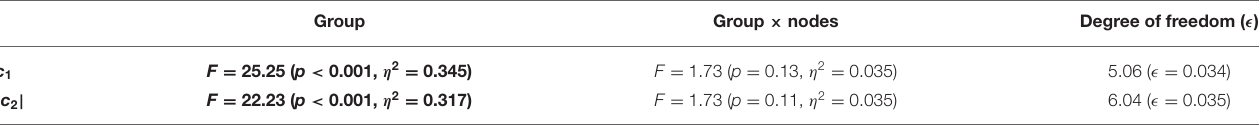
Frontiers in Aging Neuroscience |